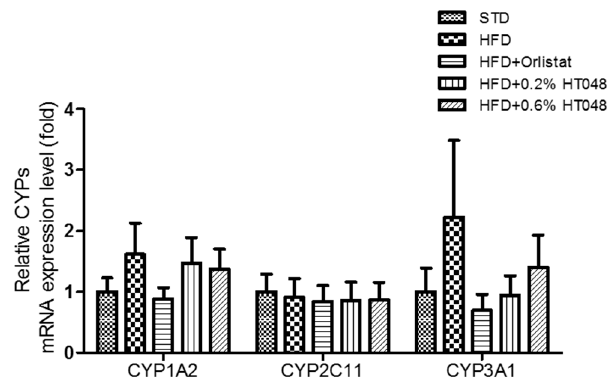
Figure 4. Effect of HT048 on mRNA expression of hepatic CYP genes in HFD-fed obese rats. Values are